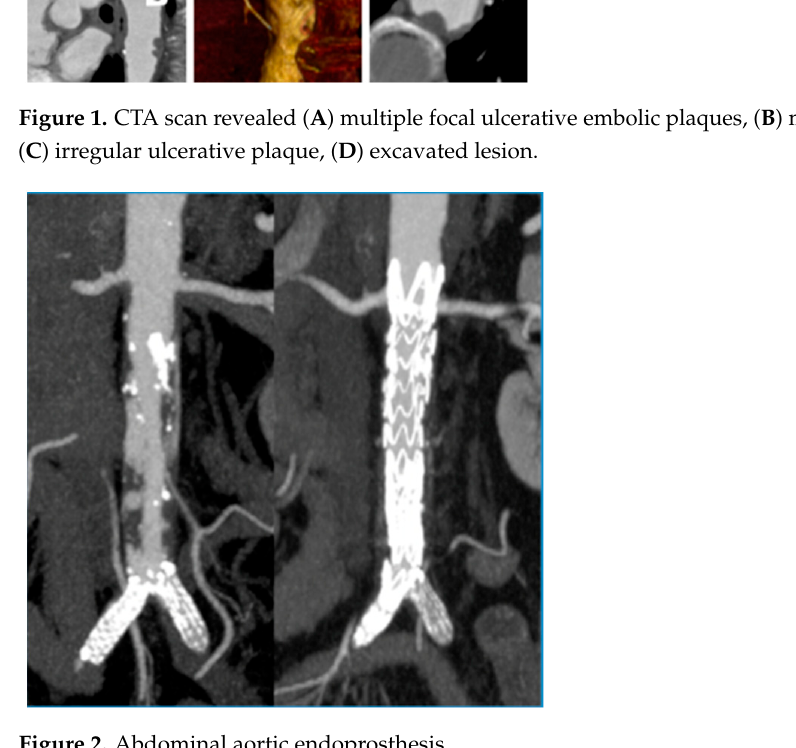
Figure 2. Abdominal aortic endoprosthesis.